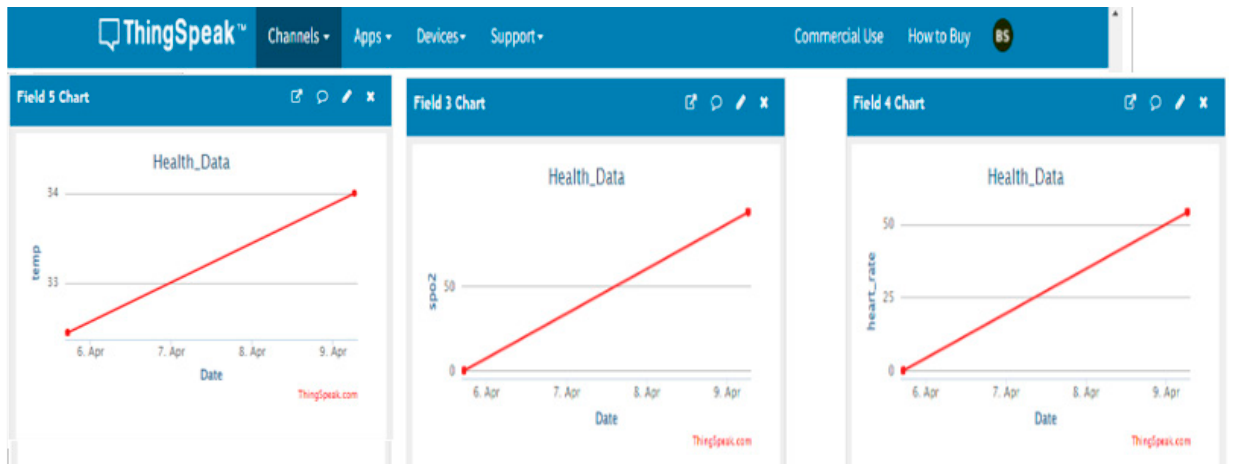
Figure 5. ThingSpeak Health Data